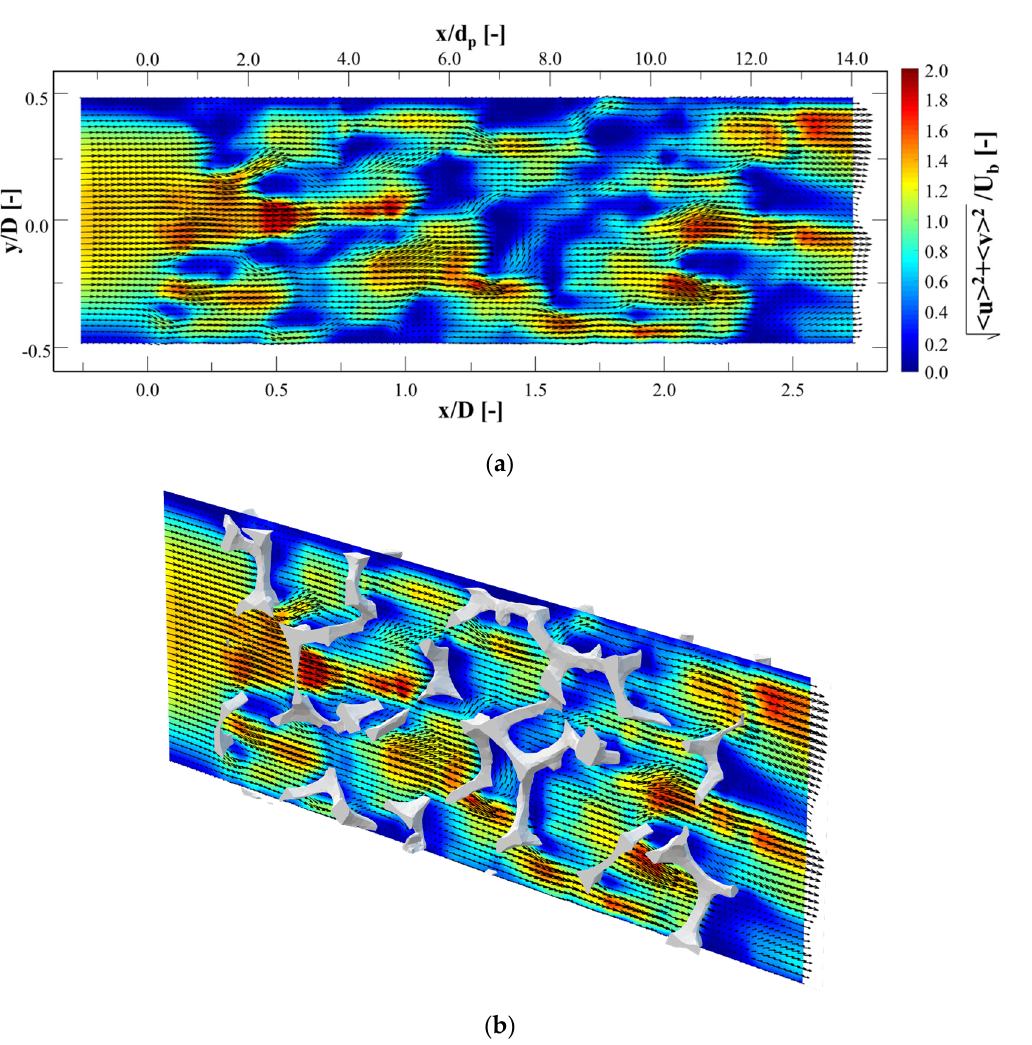
Figure 7. Contours of mean velocity magnitude on the plane at z = 0 D with superimposed vector field: ( a ) without and ( b ) with overlay of metal foam structure.